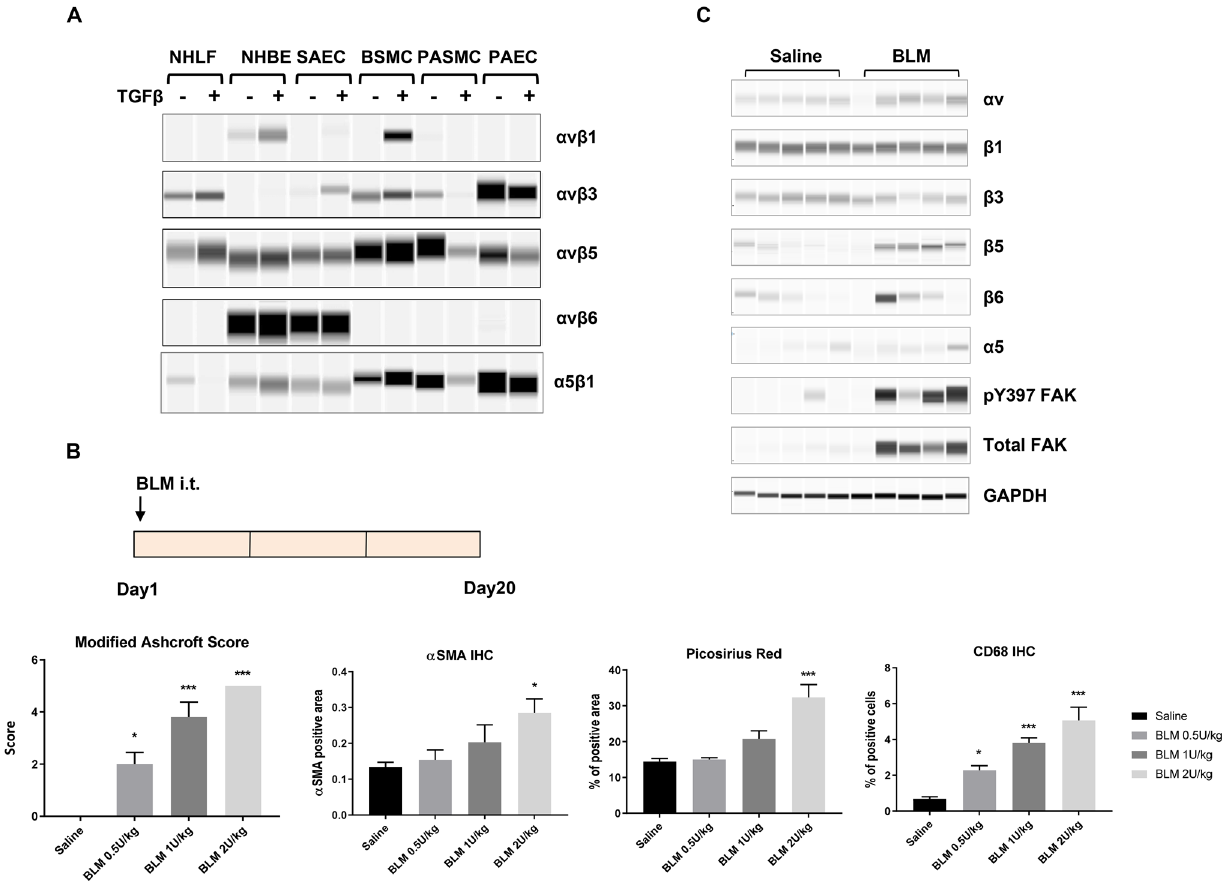
Figure 1. Changes of αv integrin expression upon fibrosis induction in the lung. ( A ) The expression of αv integrins in various human primary lung cell types upon TGFβ (5 ng/ml for 24 h) treatment. Following immunoprecipitation with an anti-αv antibody, the αvβ1, αvβ3, αvβ5, and αvβ6 heterodimers were detected by Sally Sue simple western analysis after using antibodies that recognize each individual β-subunit. Normal human lung fibroblast, NHLF; normal human bronchial epithelial cells, NHBE; small airway epithelial cells, SAEC; bronchial smooth muscle cells, BSMC; pulmonary artery smooth muscle cells, PASMC; pulmonary artery endothelial cells, PAEC. Full-length blot images are presented in Supplemental Fig. S6A–E. ( B ) Development of a bleomycin-induced lung fibrosis model in mice. Bleomycin (BLM) was administered at the indicated doses via intra-tracheal (i.t.) instillation. After 20 days, lungs were collected for histological analyses. Modified Ashcroft score, Picosirus red staining, immunohistochemical analyses of αSMA and CD68 of total lung were quantified and shown (mean ± SEM, n = 5). Immunohistochemistry, IHC. One-way ANOVA followed by Tukey’s test, *p < 0.05, **p < 0.01, ***p < 0.005 vs Saline group. ( C ) Integrin expression and signaling in fibrotic lungs (BLM 0.5U/kg bw) was determined by Sally Sue simple western analysis using antibodies that recognized the individual α or β-subunits. Each lane represents total lung homegenate for one animal, n = 5 for saline or BLM group. GAPDH level in total lung lysates was used as a loading control. Full-length blot images are presented in Supplemental Fig. benchmarking agent (Nintedanib, 60mpk, po, qd). The animals were analyzed for histology and biomarkers after treatment for 14 days (Fig. 2A). This treatment regimen allowed us to probe the efficacy of the integrin mecha- nism after bypassing the initial phase of inflammation and cytokine storm. Plasma concentration levels of MK-0429 and Nintedanib were determined at 2 h after the last dose at the end of the study. The mean plasma concentration was 3701 ± 902 ng/ml for MK-0429, and 656 ± 229 ng/ml Nintedanib (Fig. 2B), consistent with the previous report 19 . Notably, this concentration of Nintedanib exceeds the level of no-observed-adverse-effect-level (NOAEL) dose identified in mice from Nintedanib’s pharmacology review (Ref 2058320Orig1s000). Bleomycin instillation significantly decreased the bodyweight when compared to mice treated with Saline (Supplemental Fig. S2A,B). After MK-0429 and Nintedanib administration, there was no significant body weight difference between the bleomycin group and different treatment groups. There was no significant difference for percentage change of body weight among various groups. Mouse lungs were collected at Day 19 for histological evaluation. As shown by the Masson Trichrome staining (Fig. 2C), control lung tissues had normal lung struc- ture with some collagen around the bronchioles (panels a and d). Administration of bleomycin caused severe